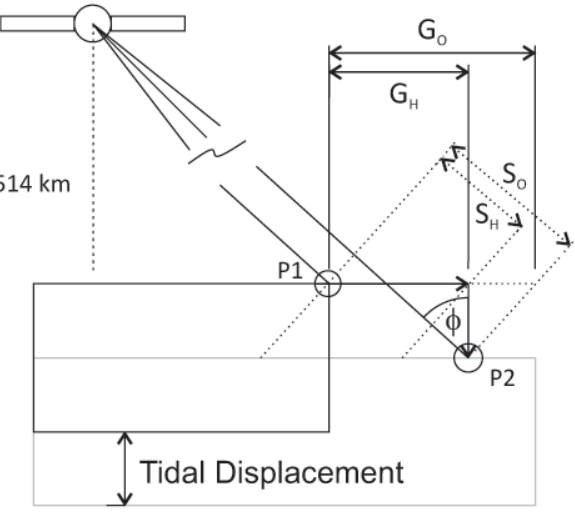
Fig. 4. Schematic showing the effect of tidal displacement on ob- served displacement in slant range ( S O ) and ground range ( G O ) compared to actual horizontal displacement ( G H ). When slant range is converted into ground range the additional displacement equals the tidal change divided by the tangent of the incidence angle ( S = T/ tan (φ)